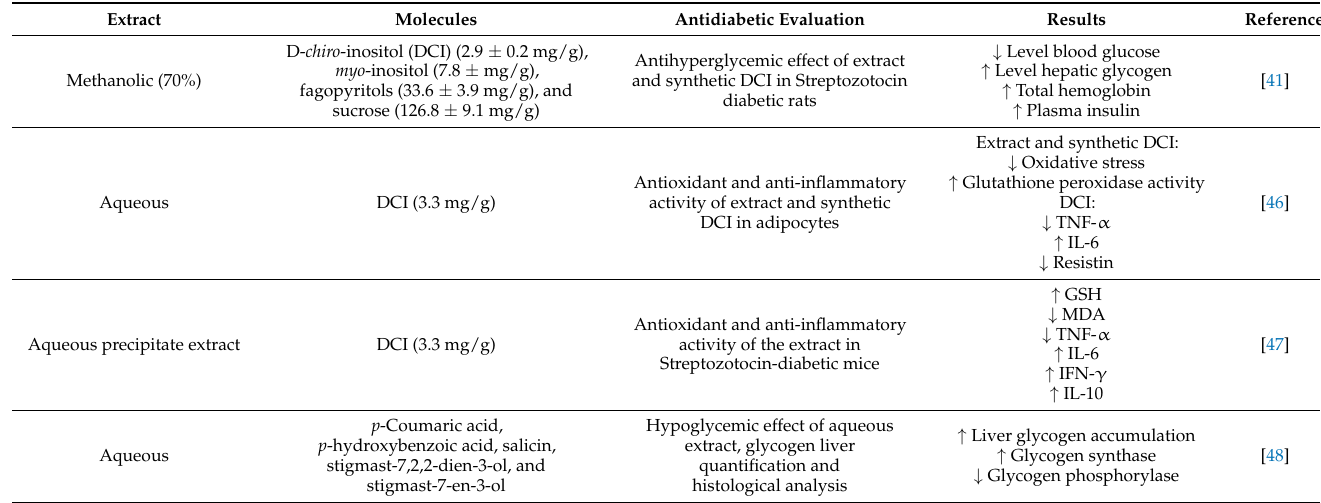
Table 1. Evaluation of the hypoglycemic, antioxidant and anti-inflammatory effects of the molecules isolated from different extracts of the fruit of C. ficifolia